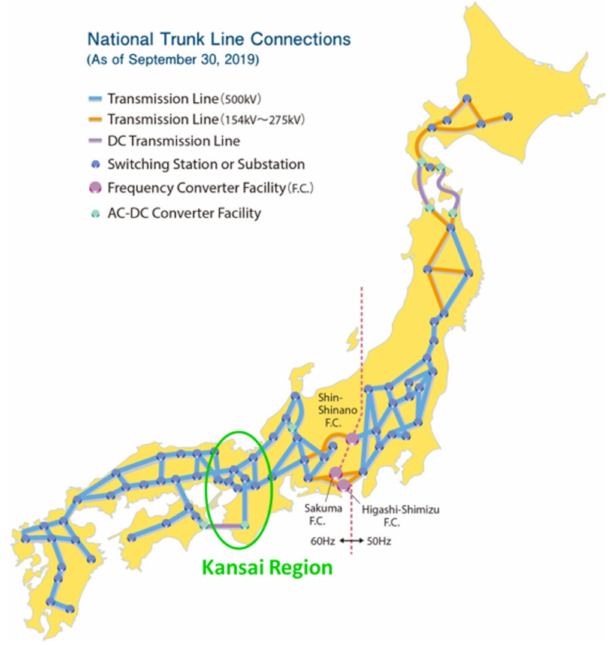
Figure 5. National power grid in Japan and the Kansai region (Based on